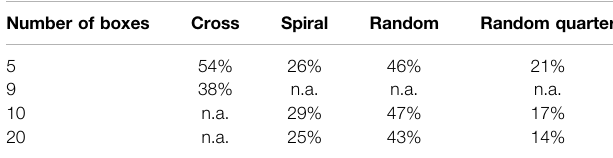
TABLE 2 | Highest achievable fi lter coverage for the implemented patterns. By its pattern, the cross layout is only feasible with fi ve or 9 boxes (3 or fi ve boxes across, respectively). The other patterns were arbitrarily set to have either 5, 10 or 20 boxes. Number of